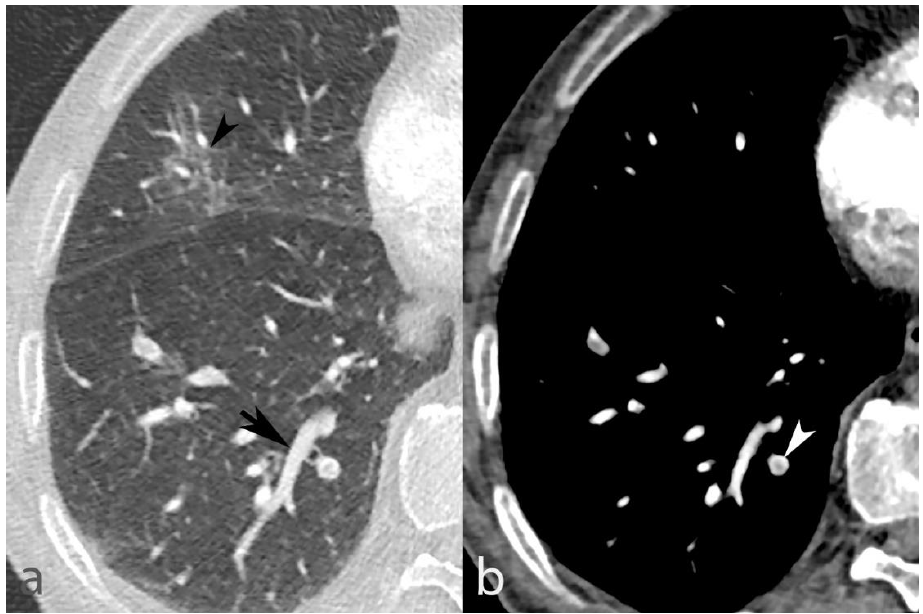
Figure 7. Mild AO in the right middle lobe (panel ( a ), black arrowhead), without associated VC in an 85-year-old man. On the other hand, distinct VC is seen in the right lower lobe (panel a , black arrow) with concomitant PE (panel ( b ), white arrowhead), supporting the potential role of VC in PE’s distribution.